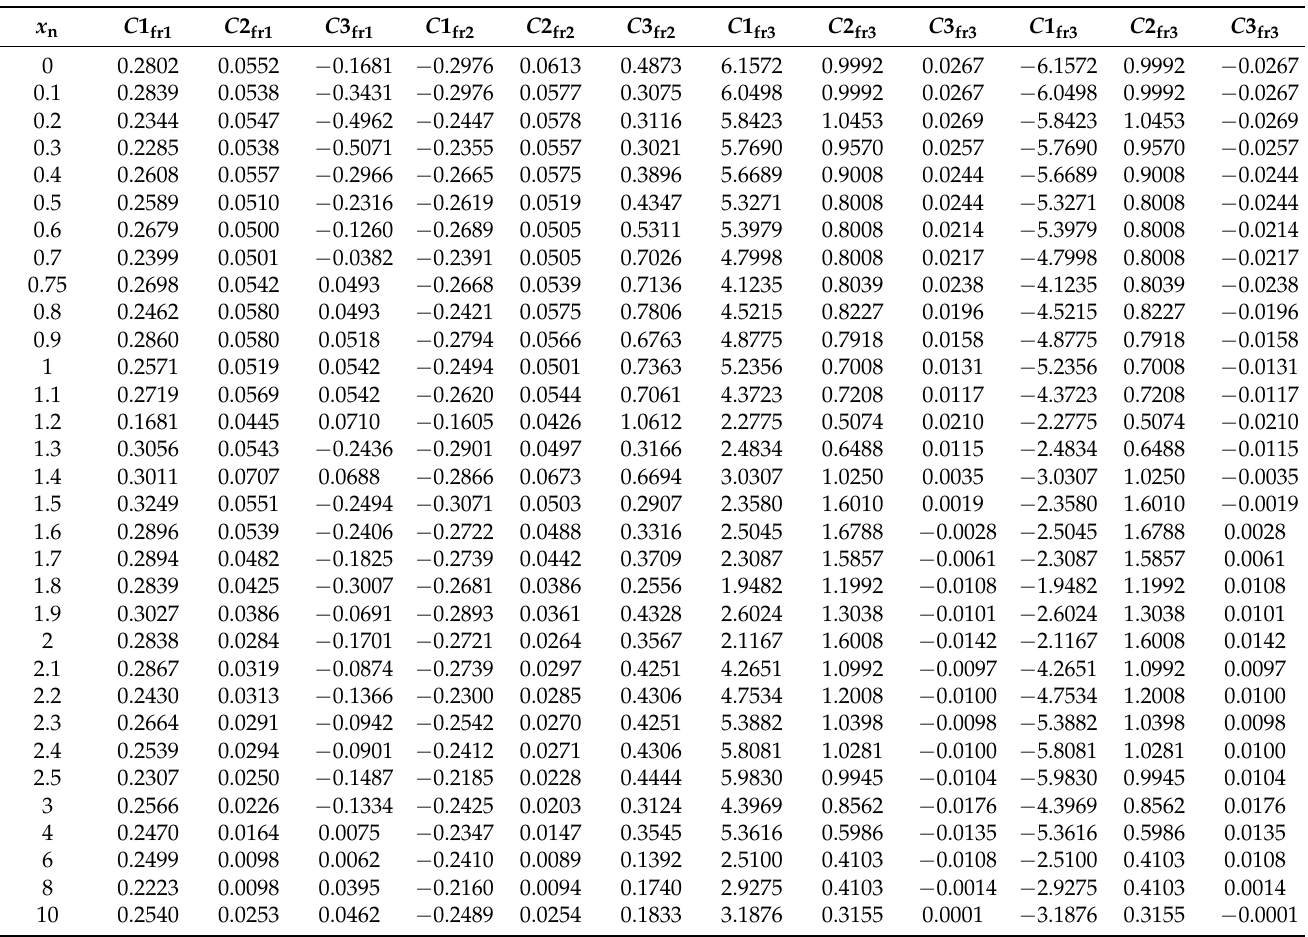
Table A6. The fitting parameters in resonance-type functions, f R_ i , ( x n ≥